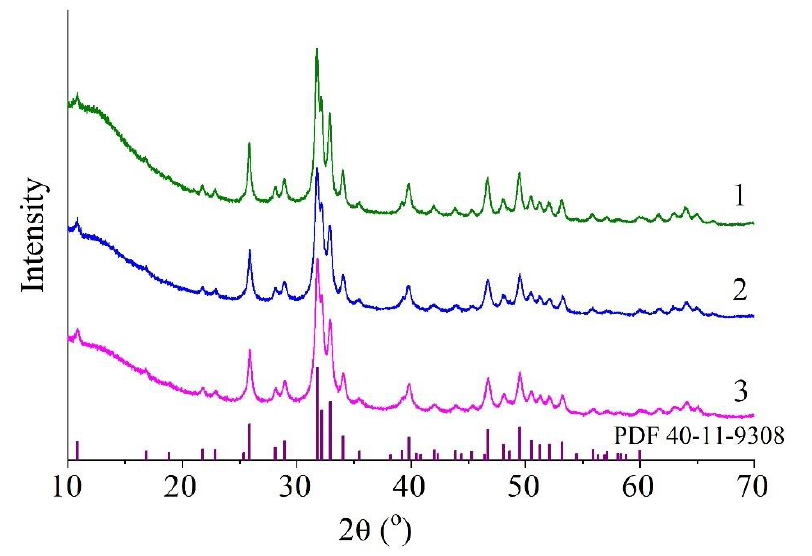
Figure 5. XRPD patterns of samples 0.0Cu ( 1 ), 0.5Cu-Ca ( 2 ), and 0.5Cu-OH ( 3 ) after synthesis according to reactions ( 1 – 3 ) (Table 1), as detected at room temperature.